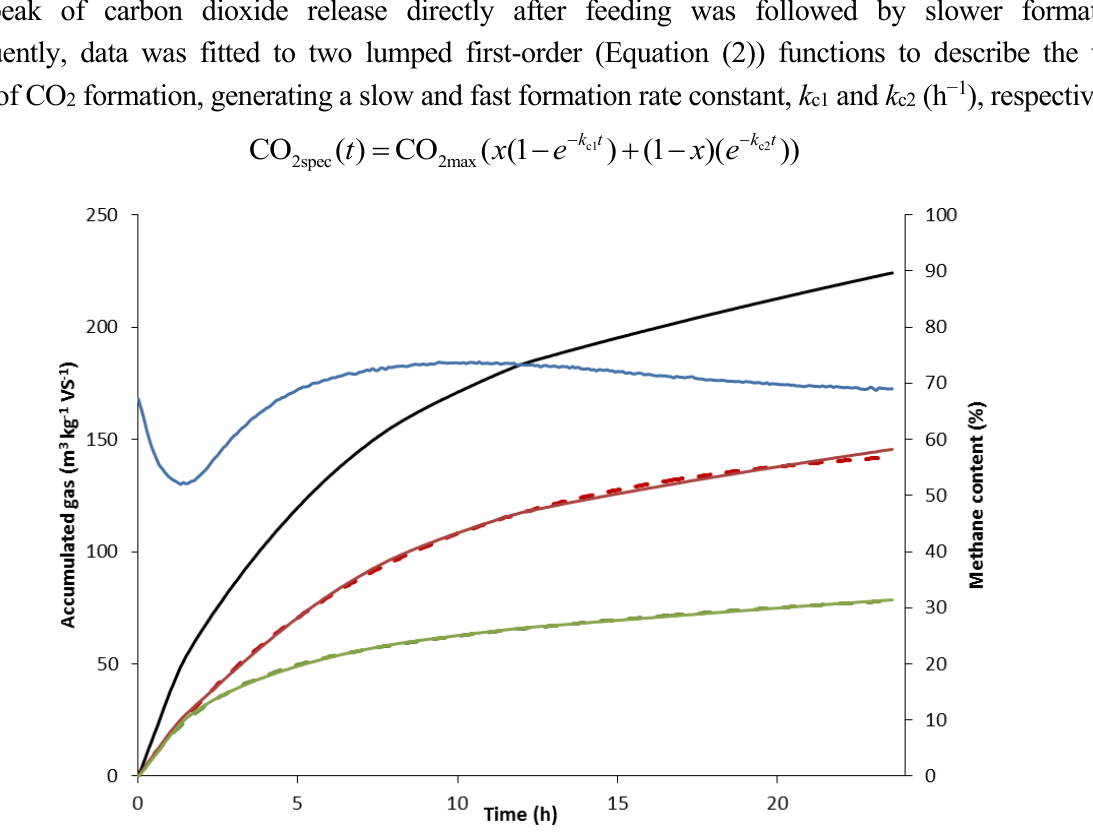
Figure 2. Total volume of biogas produced (▬), methane formed (▬), carbon dioxide formed (▬) and methane content of the gas (▬) at day 89. The dotted lines represent the curve-fitted data of methane formed (- - -) and carbon dioxide formed (- -